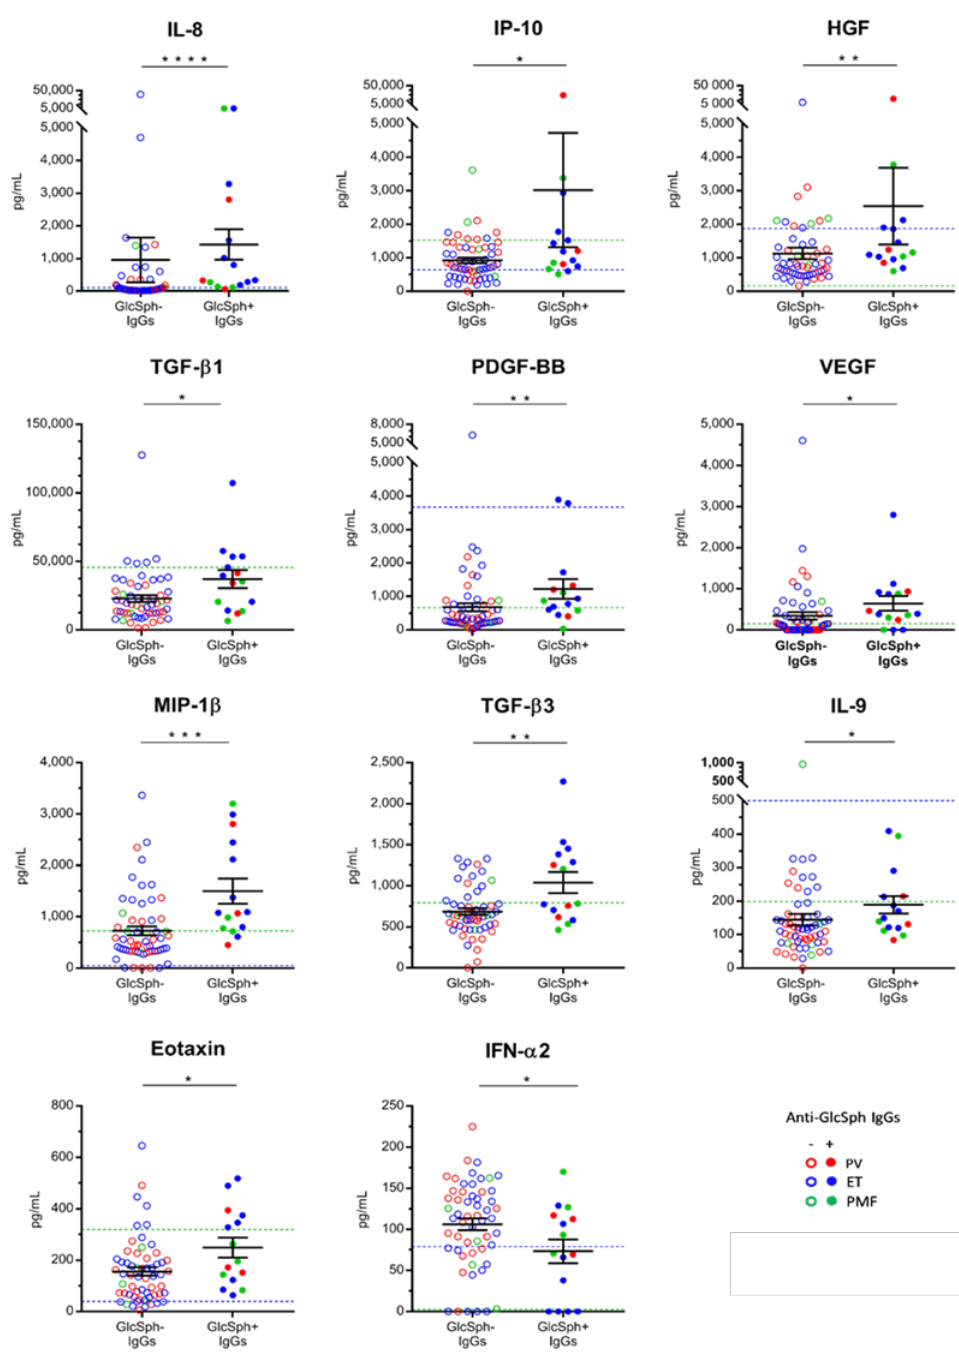
Figure 6. Cytokine levels according to the presence of GlcSph-reactive IgGs. Significant differences in the serum levels of 11 cytokines were found between MPN patients with GlcSph-reactive IgGs ( + ) and MPN patients with no GlcSph-reactive IgGs (-), as indicated. Results are presented as the means + SEM. (*) p < 0.05, (**) p < 0.01, (***) p < 0.001 and (****) p < 0.0001, Mann–Whitney t -test. Dotted blue lines represent the upper normal values observed for healthy individuals according to the manufacturers of the BioPlex Pro-human Cytokine kits, measured in 66 healthy donors. Dotted green lines represent the upper normal values for healthy individuals as measured in our control cohort of 17 healthy donors.